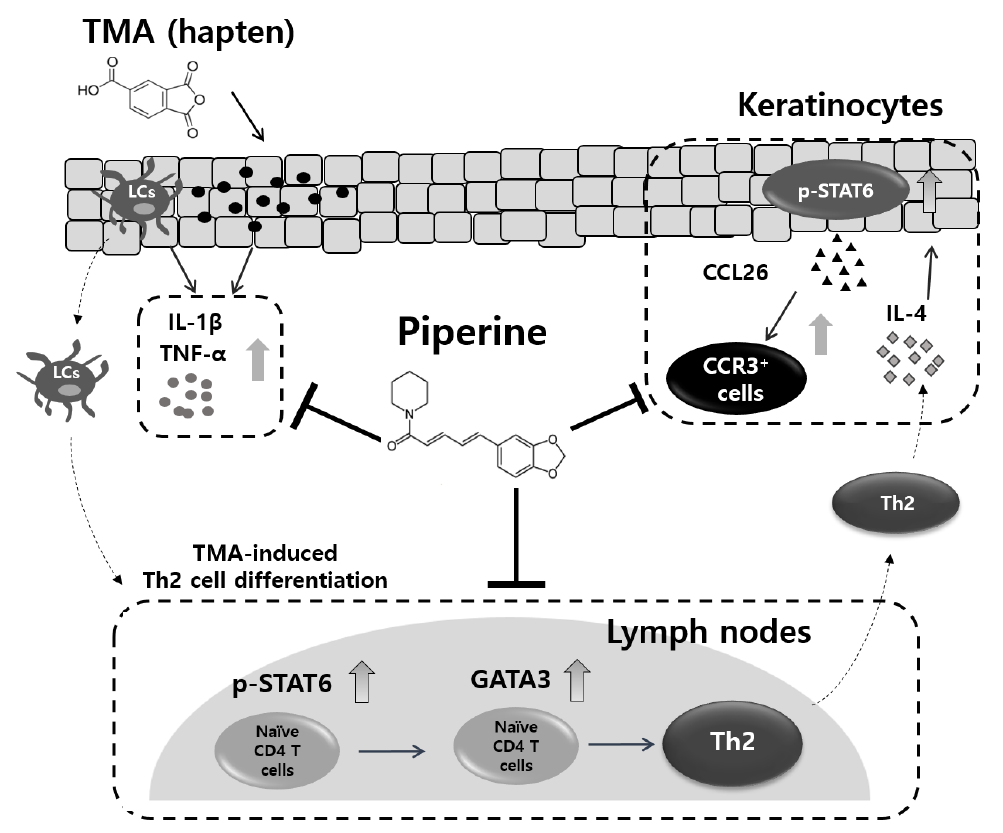
Figure 7. The proposed anti-AD effect of piperine in a TMA-induced AD-like mouse model.